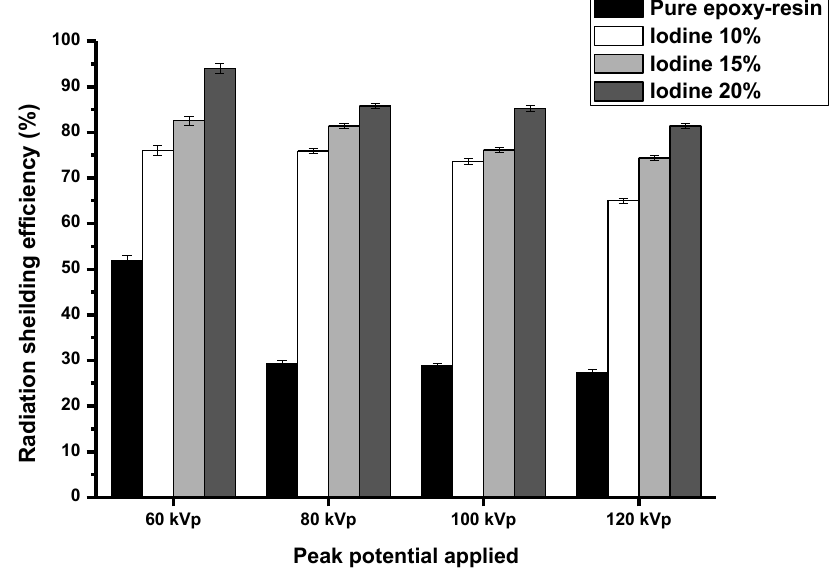
Figure 3. The X-ray dose measurement at different kVp.